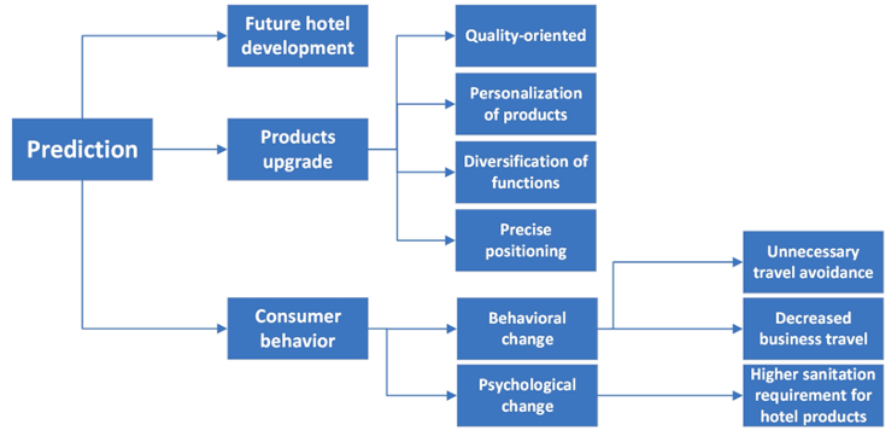
Figure 4. Prediction of hospitality and tourism development after COVID-19 pandemic.